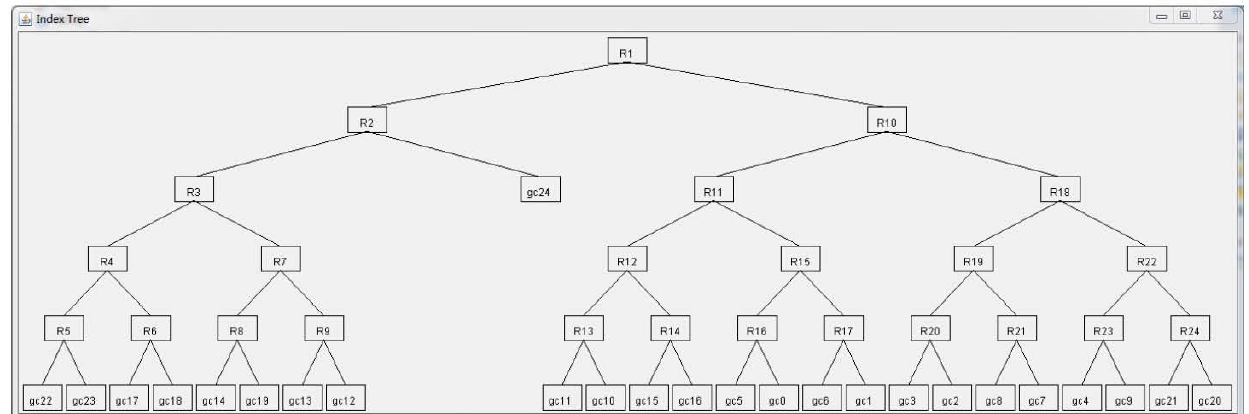
Figure 3. An example of the index tree constructed through Algorithm 1, where 1000 sensor nodes are deployed in the network region, and the skewness degree is set to 60% . The leaf nodes in the index tree correspond to the grid cells (e.g., gc correspond to sub-regions containing multiple grid cells (e.g., gc Generally, a node in an index tree corresponds to a sub-region containing a subset of tree nodes and/or sensor nodes, and these tree nodes are responsible for query